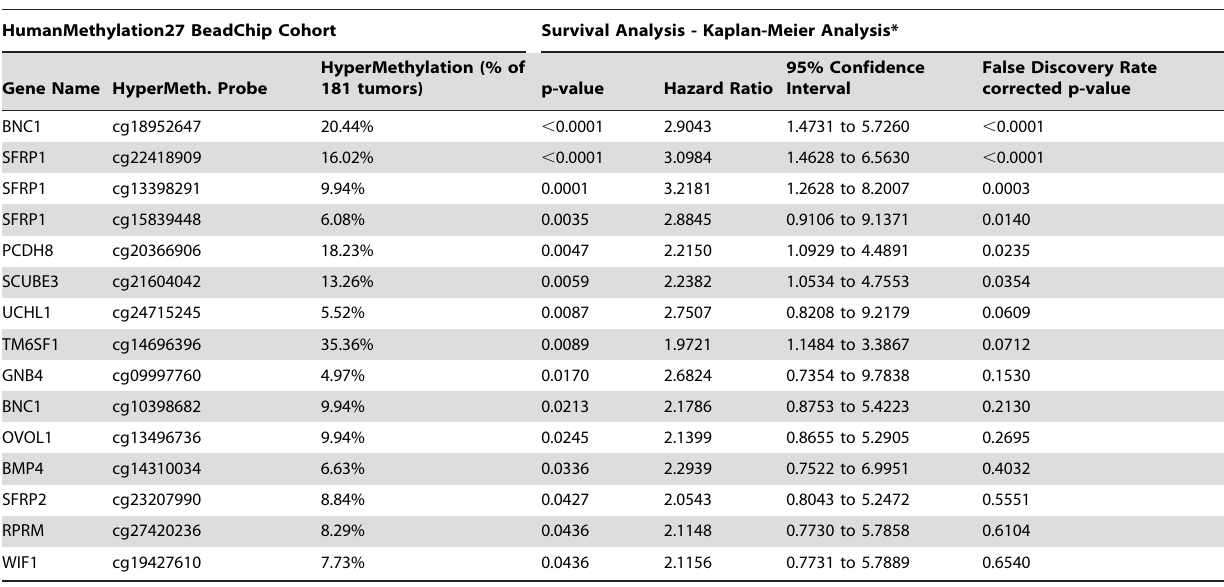
Table 3. Kaplan Meier Survival Analysis for the HumanMethylation27 BeadChip